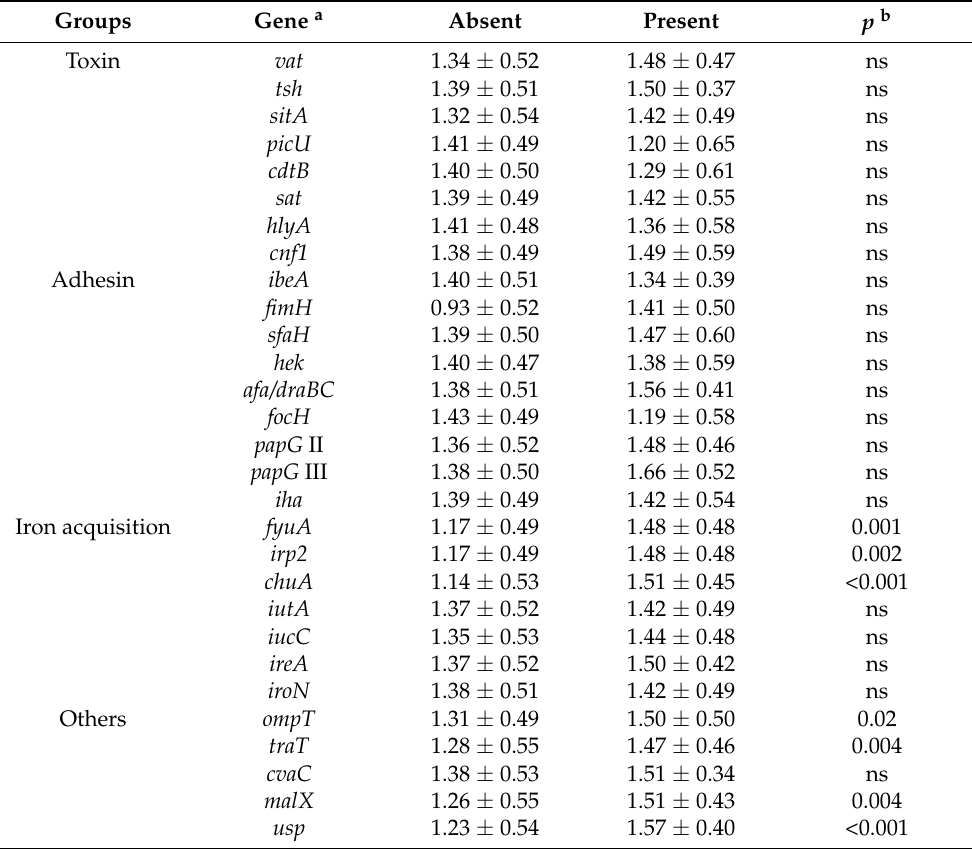
Table 2. The association between pathogenicity and virulence